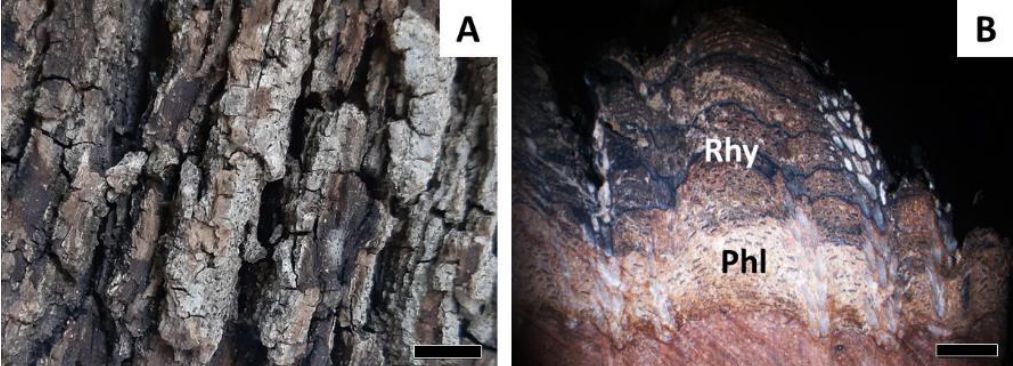
Figure 1. Bark structure of Quercus rotundifolia . ( A ) General aspects of the rhytidome; ( B ) phloem (Phl) and rhytidome (Rhy) on the transverse section. Scale bar: A = 1 cm; B = 2 mm.